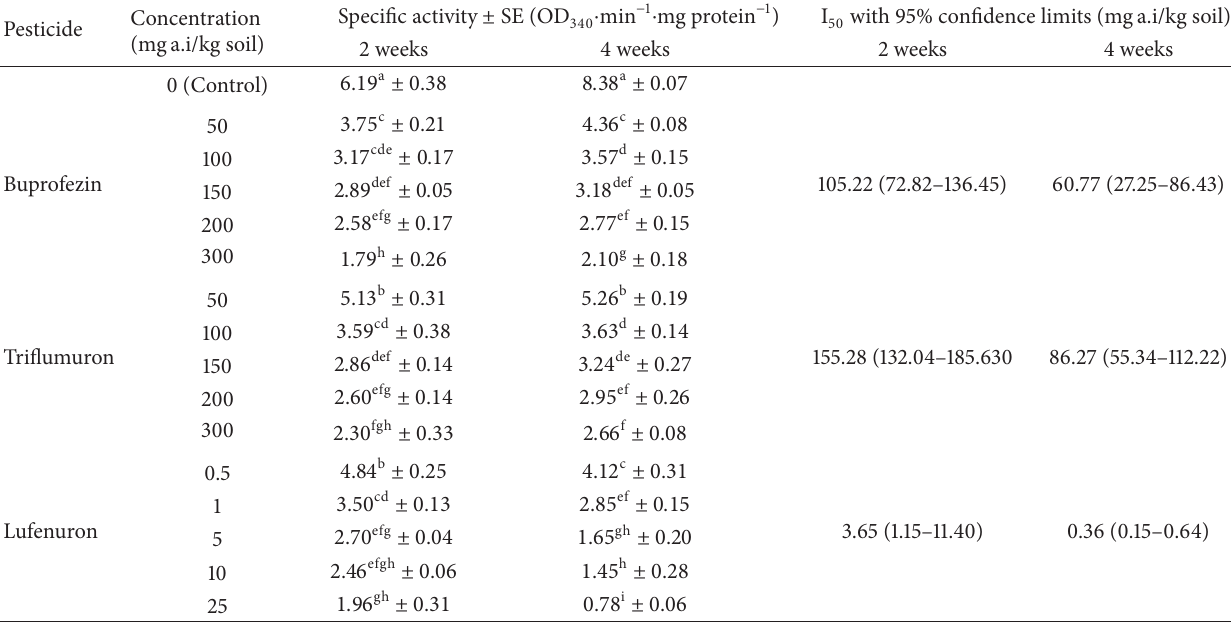
Table 5: In vivo effect of different application rates of buprofezin, triflumuron, and lufenuron on GST activity in earthworm after 2, 4, weeks of treatment.